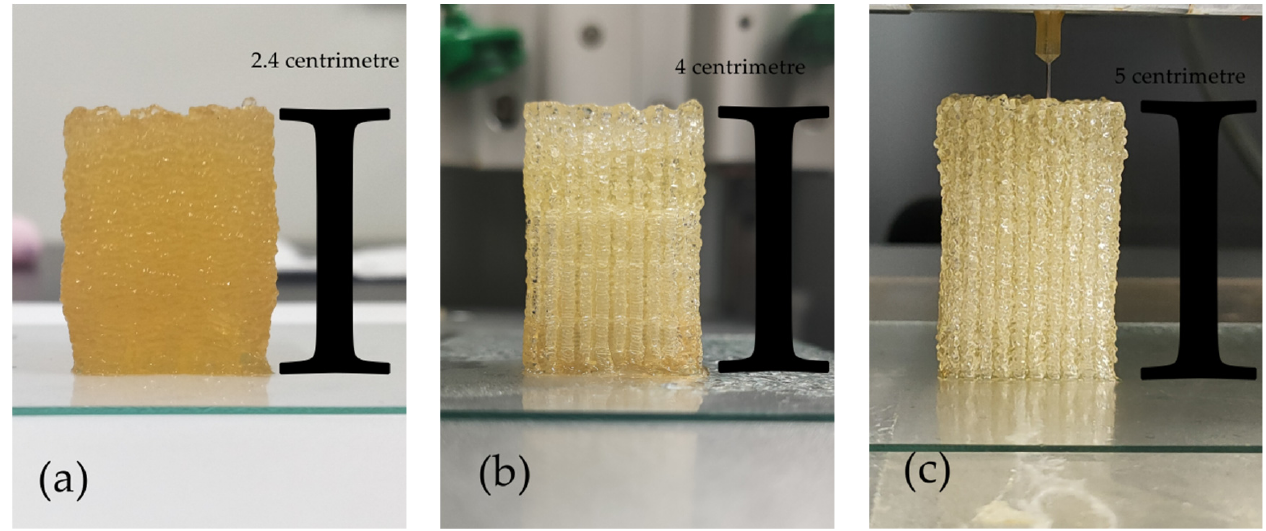
Figure 8. Structures constructed with different concentrations of agarose: ( a ) 0%, ( b ) 0.2%, ( c ) 0.4%.